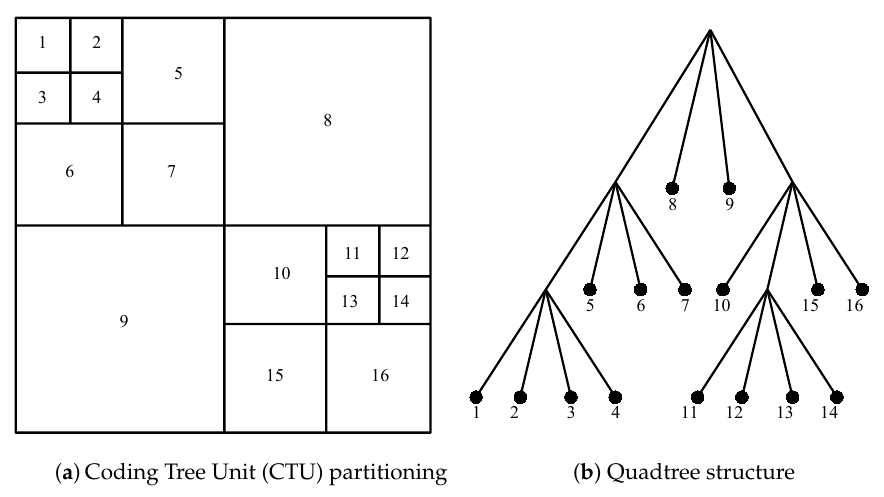
Figure 2. ( a ) Sample Partitioning structure of a typical CTU and ( b ) the corresponding quadtree